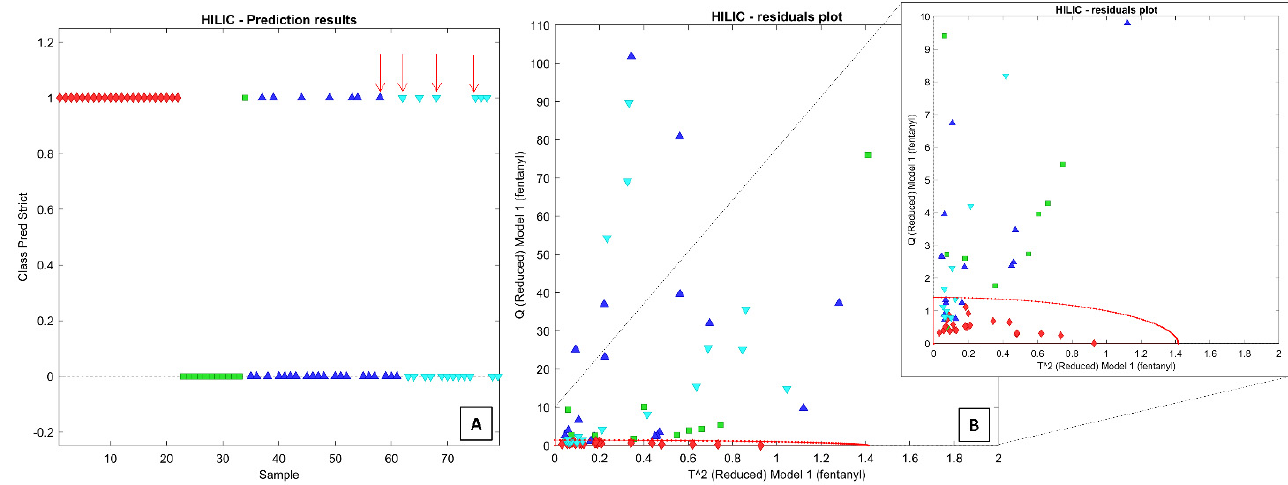
Figure 5. SIMCA models obtained with the HILIC dataset: ( A ) reports the prediction results and ( B ) the residuals plot. The red arrows indicate the misclassified samples by both the SIMCA models built on RP and HILIC datasets.